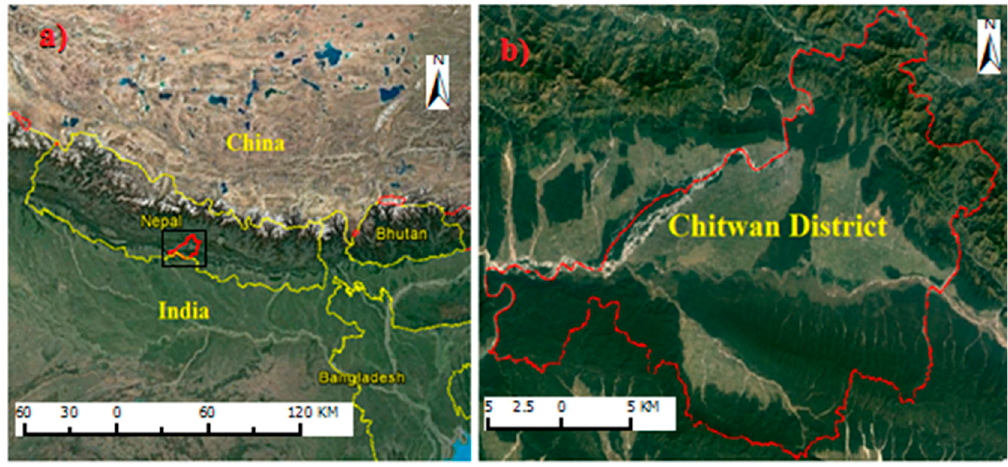
Figure 1. The geographical location of ( a ) Nepal and ( b ) Chitwan district.